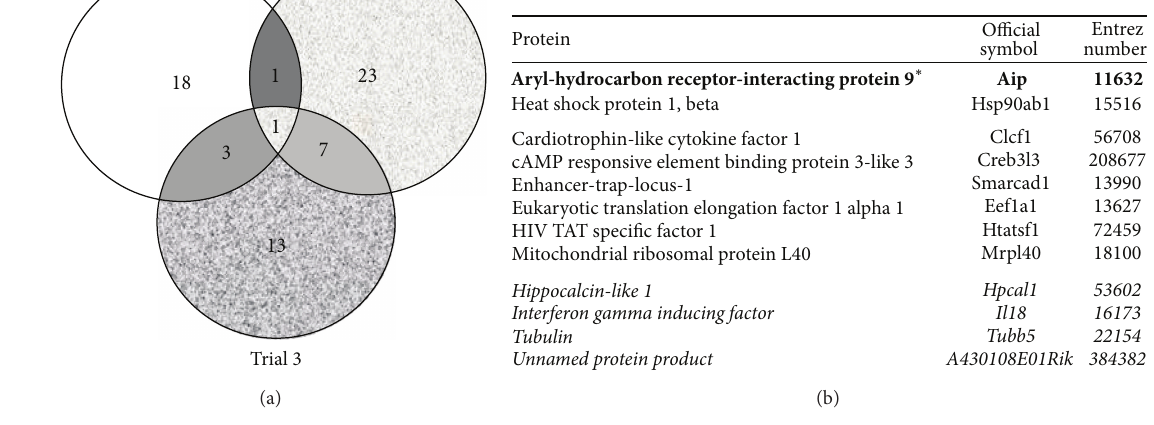
Figure 3: TCDD 30-minute treatment data set. (a) Venn diagram of proteins identified by mass spectrometry in 3 data sets of AHR-TAP 30 min TCDD (10nM) dosing. (b) Table listing of proteins identified in two out of three data sets. Bold type with ∗ denotes a protein represented in all three data sets. Italicized type denotes nonspecific proteins identified in both AHR-TAP and GFP-TAP